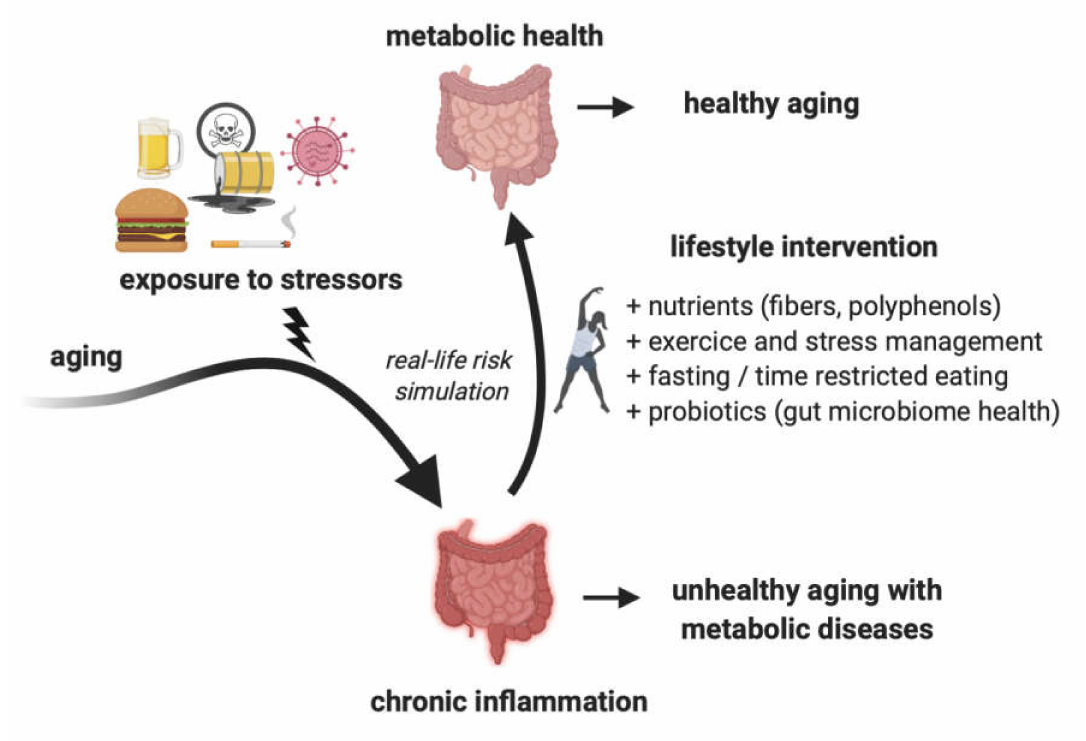
Figure 3. Lifestyle changes can promote healthy aging by mitigating the deleterious e ff ects of stressors. Exposure to a variety of stressors (processed food, overfeeding, environmental toxicants, infectious agents, or drugs) during life course can promote chronic inflammation and the development of metabolic disorders. A large number of real-life risk simulation studies showed that this can be mitigated by lifestyle